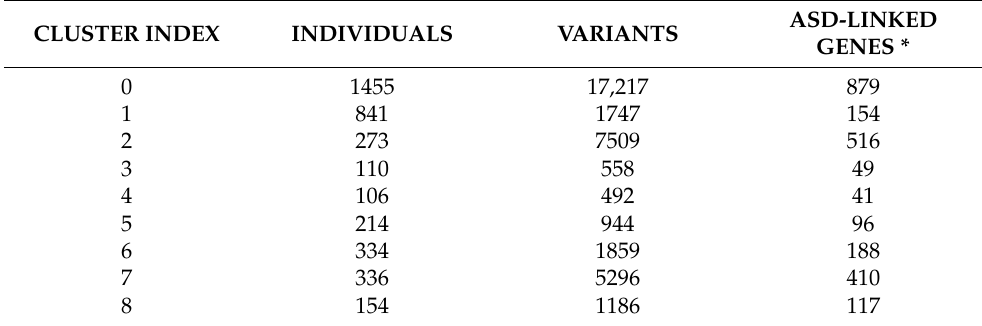
Table 1. Number of individuals, genetic variants, and ASD-linked genes included in each cluster. CLUSTER